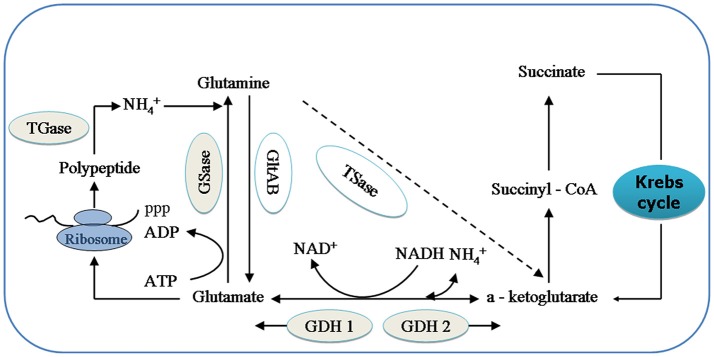
The relationship between relative enzymes and ammonia (NH4+). Key intermediates and enzymes related to synthesize and catalyze are shown. GSase, glutamate synthase; TSase, Transaminase; GDH 1, NADH—dependant—glutamate dehydrogenase; and GDH 2, NAD+- dependant glutamate dehydrogenase; GSase, glutamine synthetase and TGase, Transglutaminase.